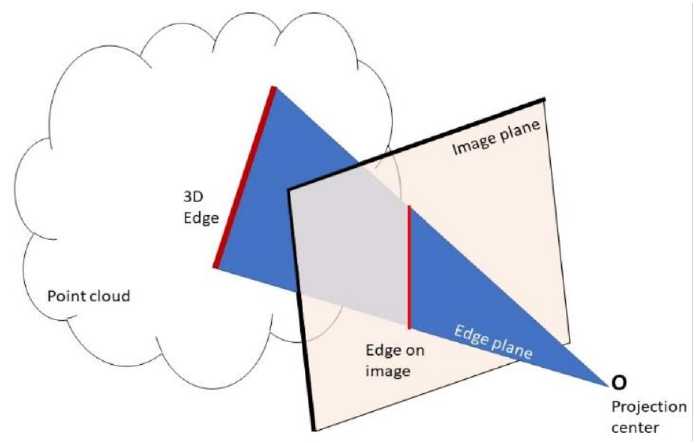
Figure 1. The main idea of the proposed